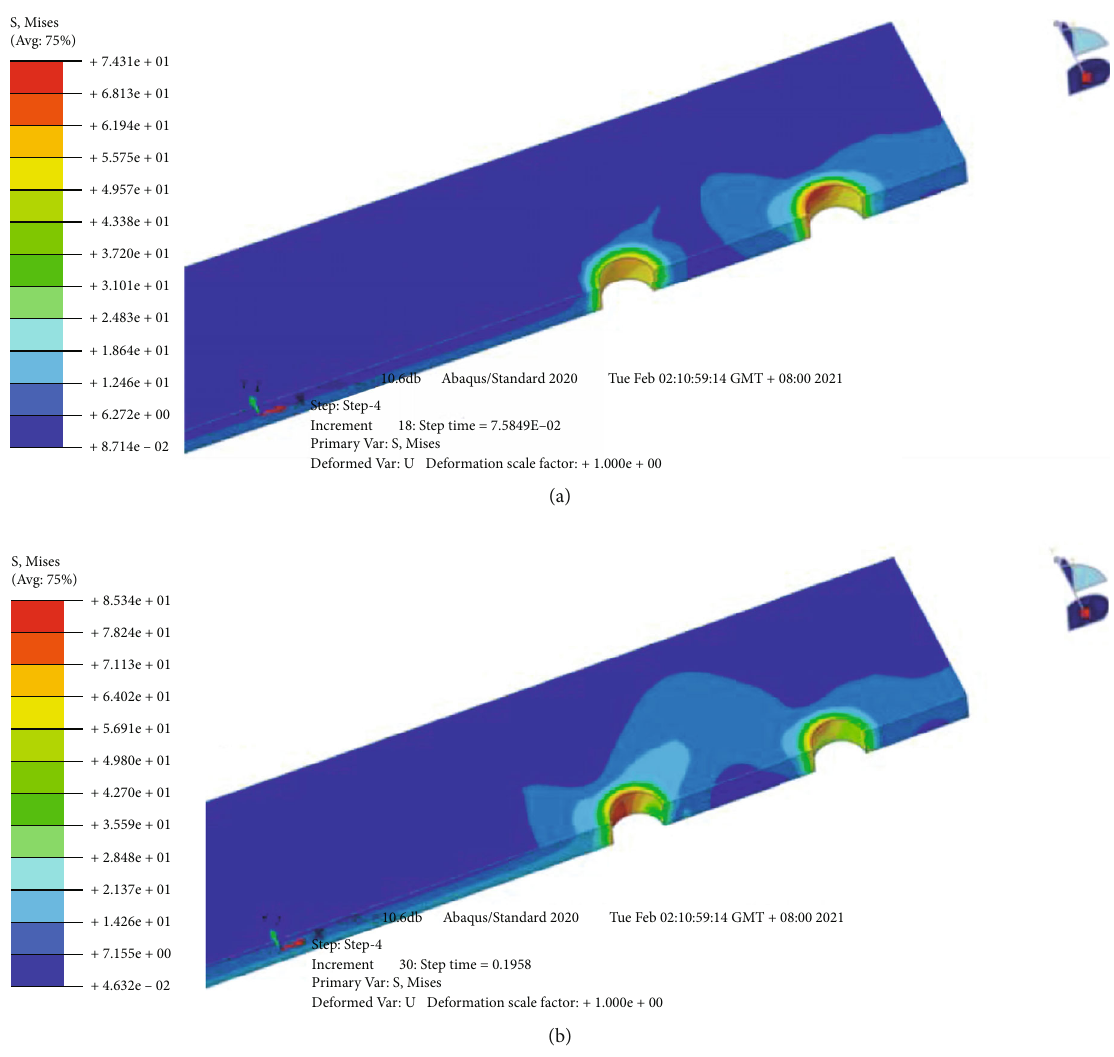
Figure 9: Mises stress contour maps of the ceramic matrix composite plate for the studied joint with 10mm edge distance at the applied loading levels of 700 N (a) and 1250 N (b) at 750 °